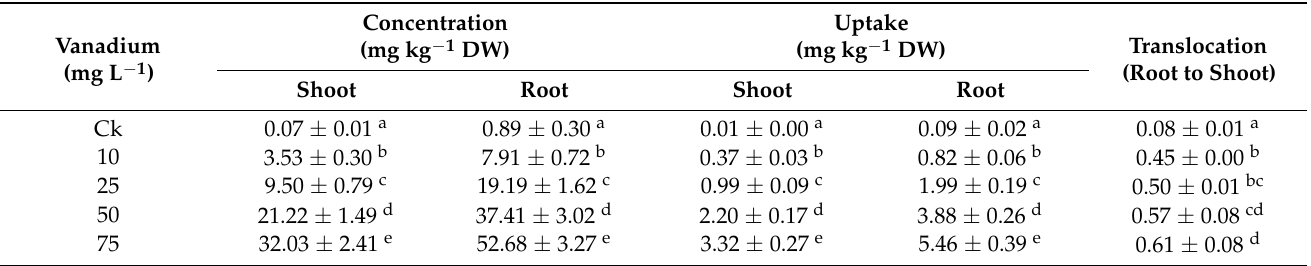
Figure 3. The influence of various V treatments on leaf gas exchange elements; ( A ) transpiration rate, ( B ) photosynthetic rate, ( C ) stomatal conductance, and ( D ) intercellular CO 2 . Duncan’s test indicates a significant difference ( p < 0.05) between the means of the five treatments indicated by different alphabets. Table 3. The influence of various V treatments on the concentrations, uptake, and translocation (root to shoot) of